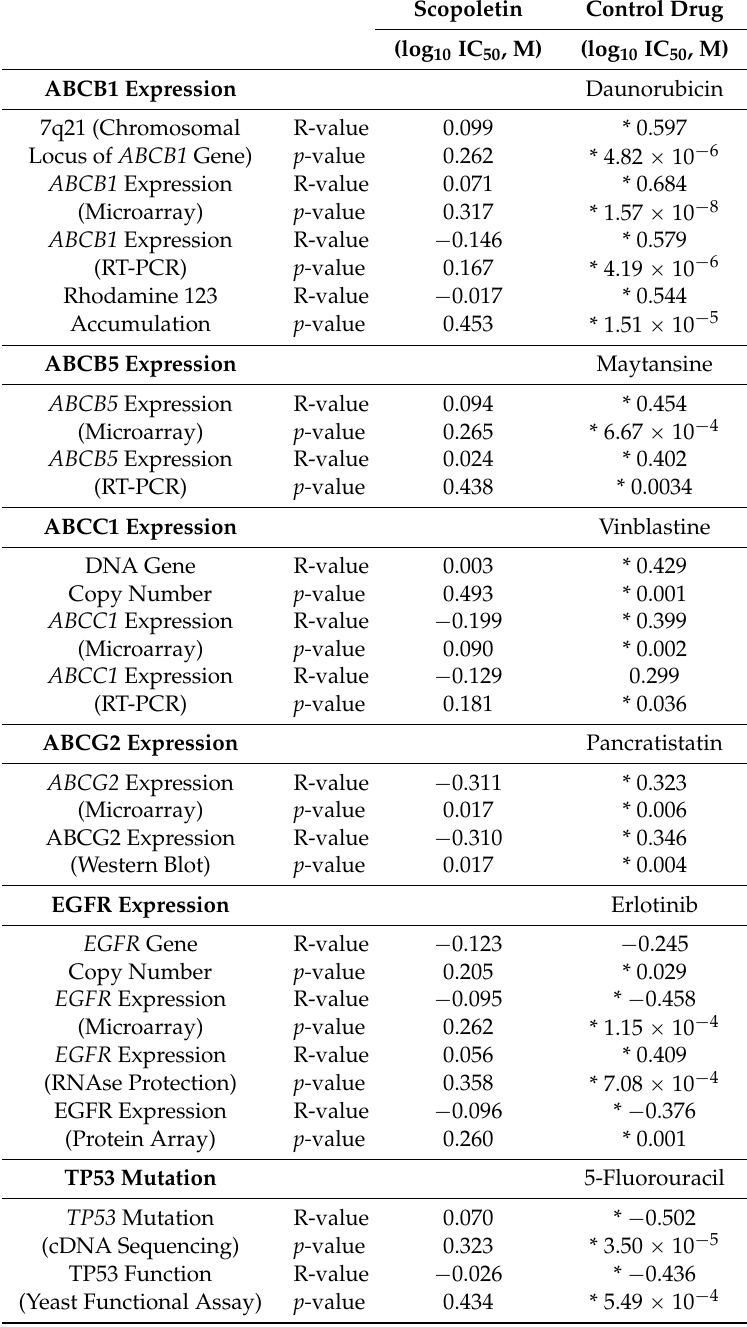
Table 1. Correlation of log 10 IC 50 values for scopoletin to ABC transporters, oncogenes and tumor suppressor genes in the NCI cell line panel. Known standard compounds were used as positive controls. The analysis was performed by means of Pearson’s rank correlation